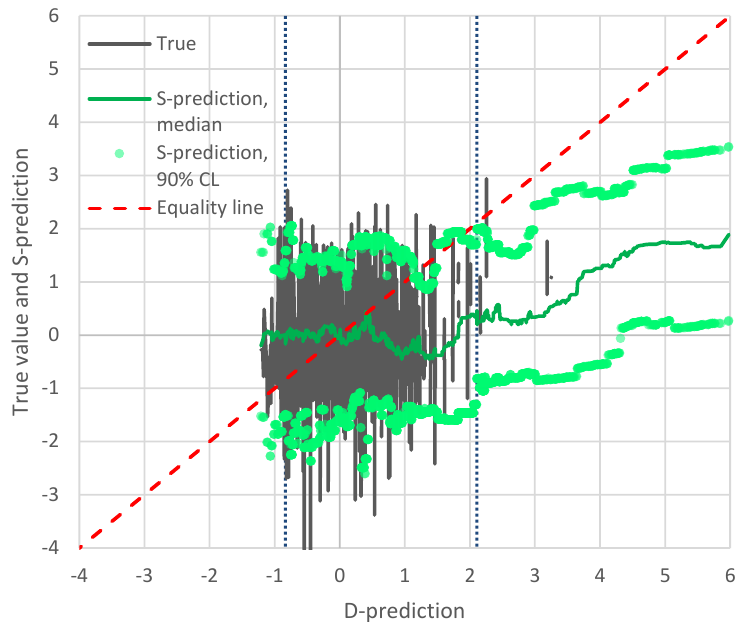
Figure 4. True values vs. D-model predictions for temperature, along with the S-model predictions (median and 90% confidence limits). The vertical dotted lines define the area out of which extrapolation is necessary.